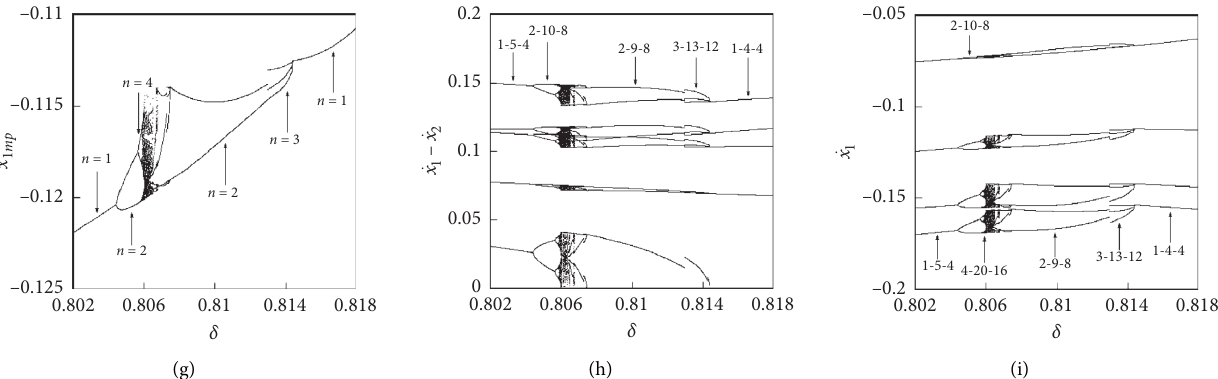
Figure 6: Bifurcation maps of nonhysteretic transition region of adjacent basic periodic impact vibrations 1-4-4 and 1-5-5, ω � 0.272. (a)